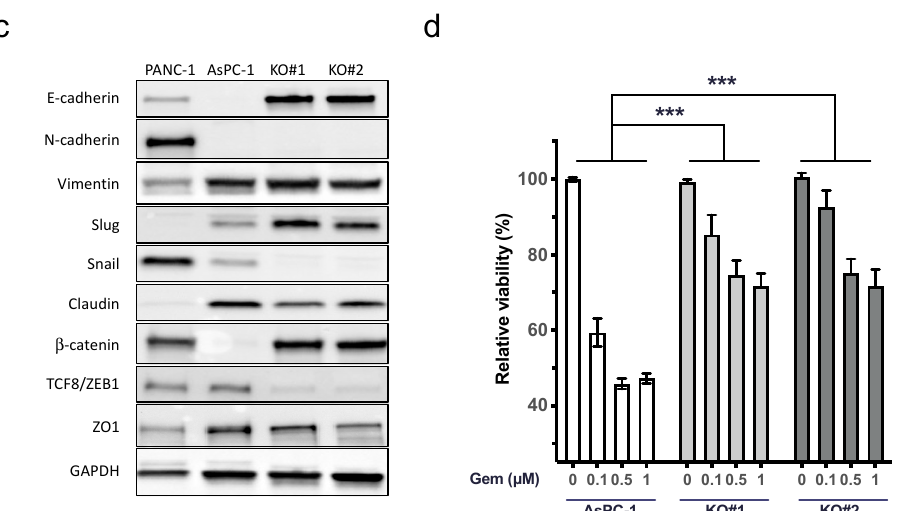
Figure 2. Decreased cell growth, motility, and response to gemcitabine of AsPC uPAR knockout clones. ( a ) Cell growth analysis (6 days) of uPAR − / − clones with a significantly slower proliferation rate than WT controls ( n = 3). ( b ) Reduced migratory capacity of AsPC-1 uPAR − / − clones compared to uPAR WT cells ( n = 3). ( c ) Western blot analysis of 9 epithelial and mesenchymal markers in PANC-1, AsPC-1, and uPAR − / − clones indicated mesenchymal to epithelial transition (MET) in uPAR − / − cells. Uncropped Western blot images available in Supplementary Material File S1 ( d ) Increased resistance of uPAR − / − clones to gemcitabine treatment (0.1, 0.5 and 1 µ M) for 72 h ( n = 4 biological replicates). (KO#1 and KO#2, uPAR − / − clones) (*** p < 0.001).